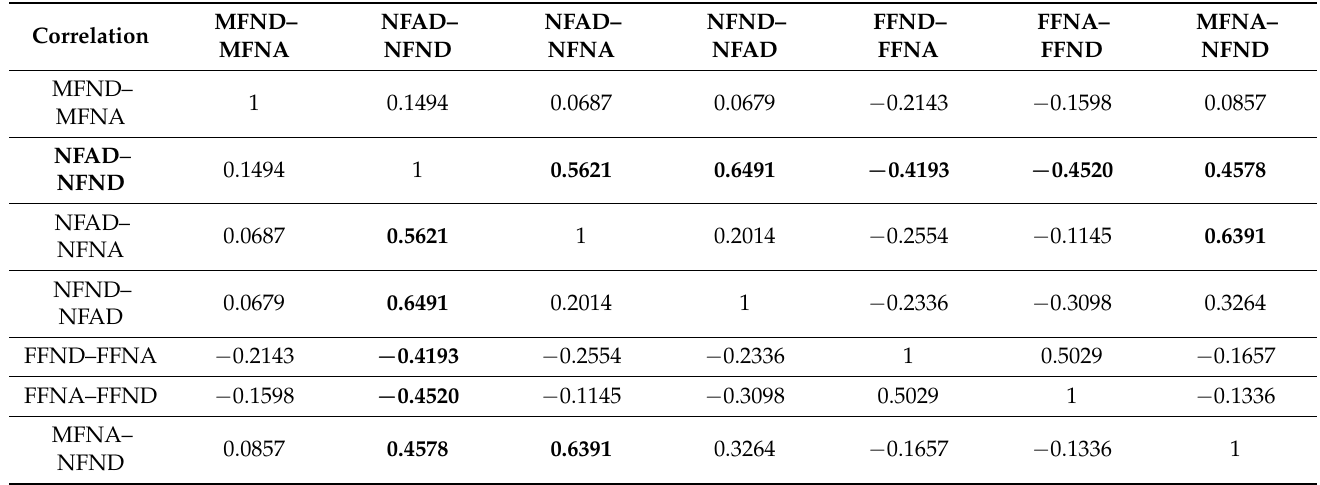
Table 6. Pearson correlation coefficients between the seven transition probabilities.